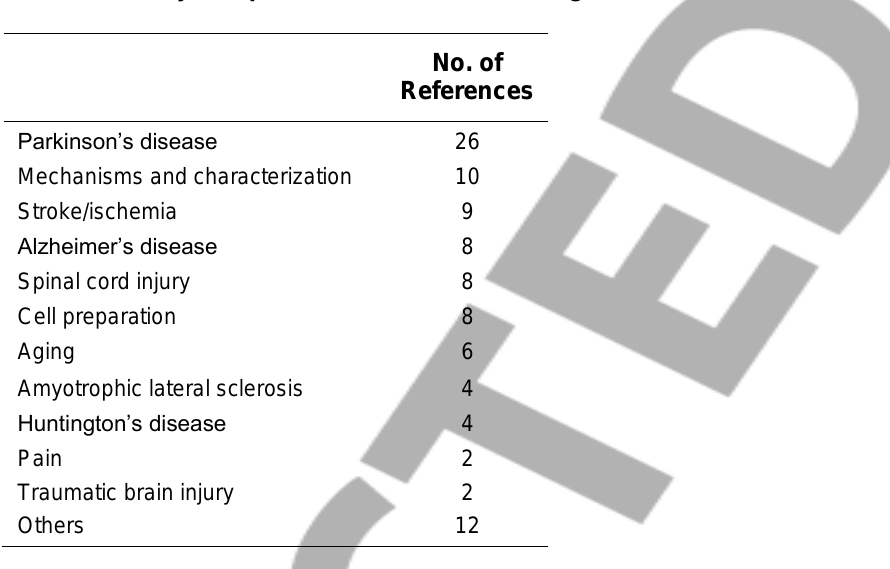
Distribution of Major Topics in 2009 ASNTR Meeting